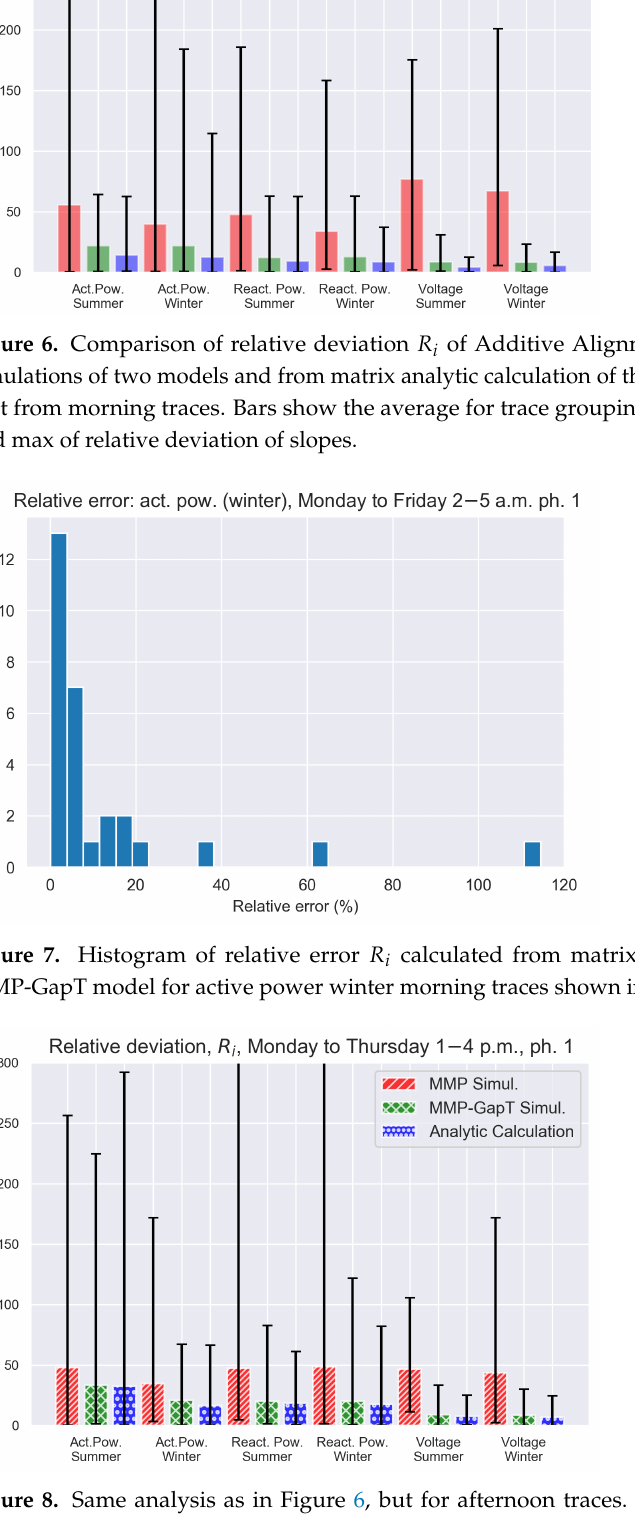
Figure 8. Same analysis as in Figure 6, but for afternoon traces. Note that vertical bars for the MMP simulations of reactive power summer and winter were clipped for improved presentation. Maximum values for these MMP simulation groups are 347% and 472%,